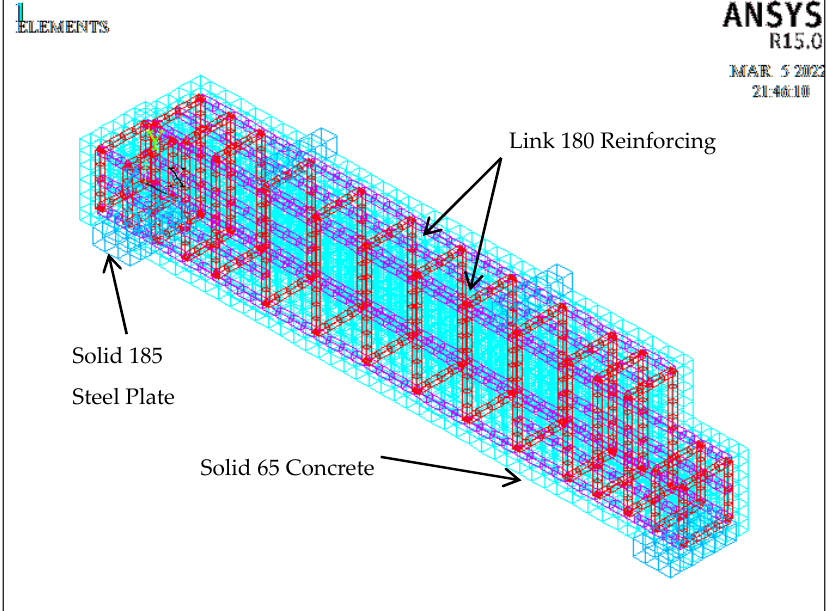
Figure 11. Modelling details of the elements for all the materials for typical RC girder models with dapped ends.